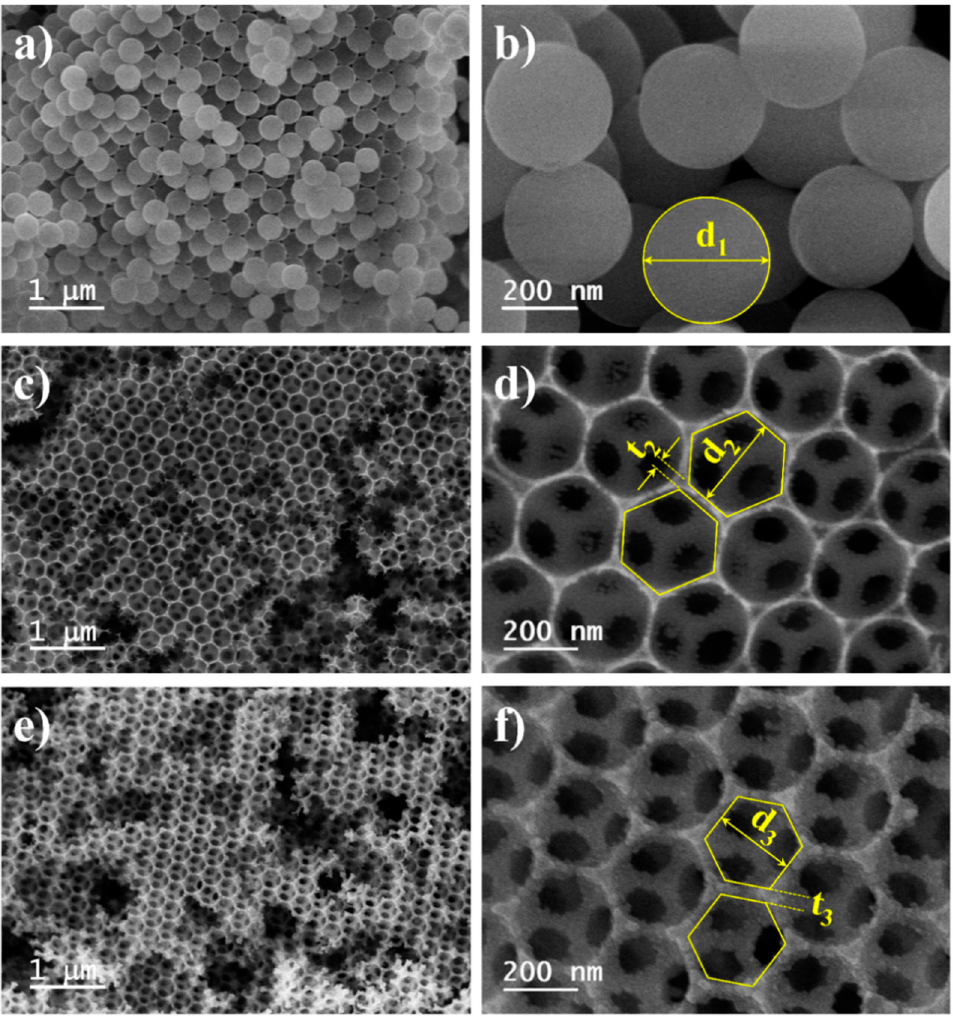
Figure 1. SEM images of ( a , b ) the PS spheres, ( c , d ) IP-TiO 2 , and ( e , f ) Ag@IP-TiO 2 ; the images on the right side ( b , d , f ) are acquired with a higher magnification.